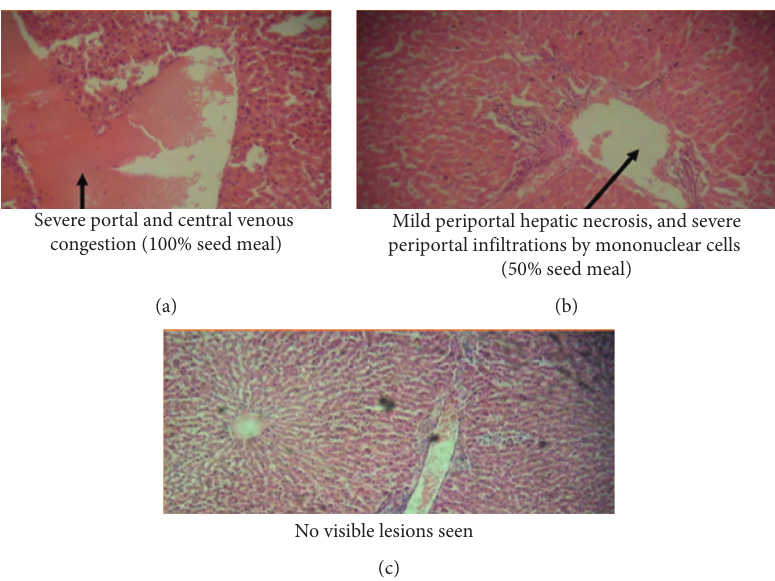
Figure 4: Effect of (a) 100% seed meal and (b) 50% seed meal on the liver of Wister albino rats. (c) Rat chow